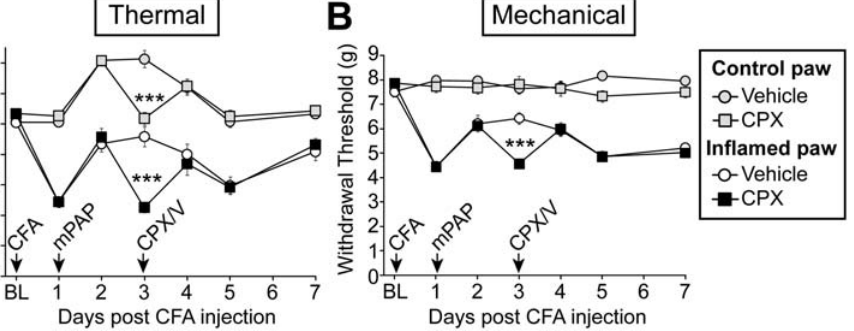
Figure 6. The antinociceptive effects of mPAP can be transiently inhibited with a selective A 1 R antagonist. Wild-type mice were tested for (A) noxious thermal and (B) mechanical sensitivity before (baseline, BL) and following injection of CFA (CFA-arrow) into one hindpaw. The non- inflamed hindpaw served as control. All mice were injected with active mPAP (mPAP-arrow; 2 U, i.t.). Two days later, half the mice were injected with vehicle (CPX/V-arrow, circles; intraperitoneal (i.p.); 1 hr before behavioral measurements) while the other half were injected with 8-cyclopentyl-1, 3- dipropylxanthine (CPX/V-arrow, squares; 1 mg/kg i.p.; 1 hr before behavioral measurements). There were significant differences over time between mice injected with vehicle and mice injected with CPX (Repeated measure two-way ANOVA; P , 0.01). Post-hoc paired t-tests were used to compare responses at each time point between vehicle (n=10) and CPX-injected mice (n=10); same paw comparisons. *** P , 0.0005. All data are presented as means 6